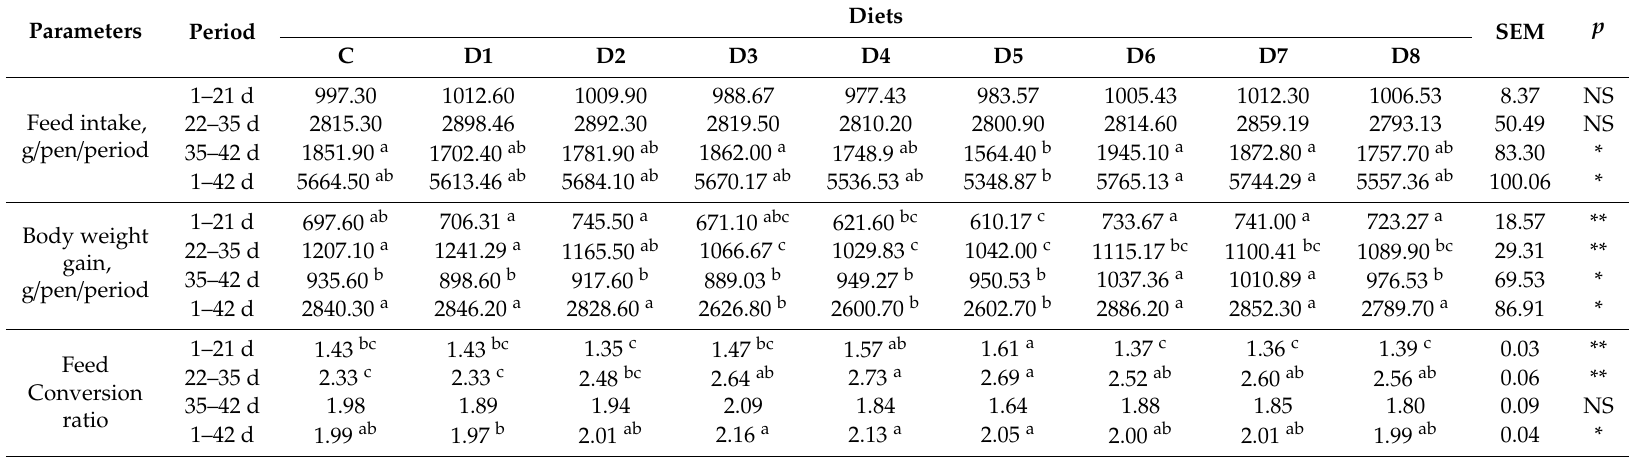
Table 3. Growth performance of Ross 308 broilers fed diets containing di ff erent levels of L-carnitine and lysine-methionine from day 1 to day 42 of age.